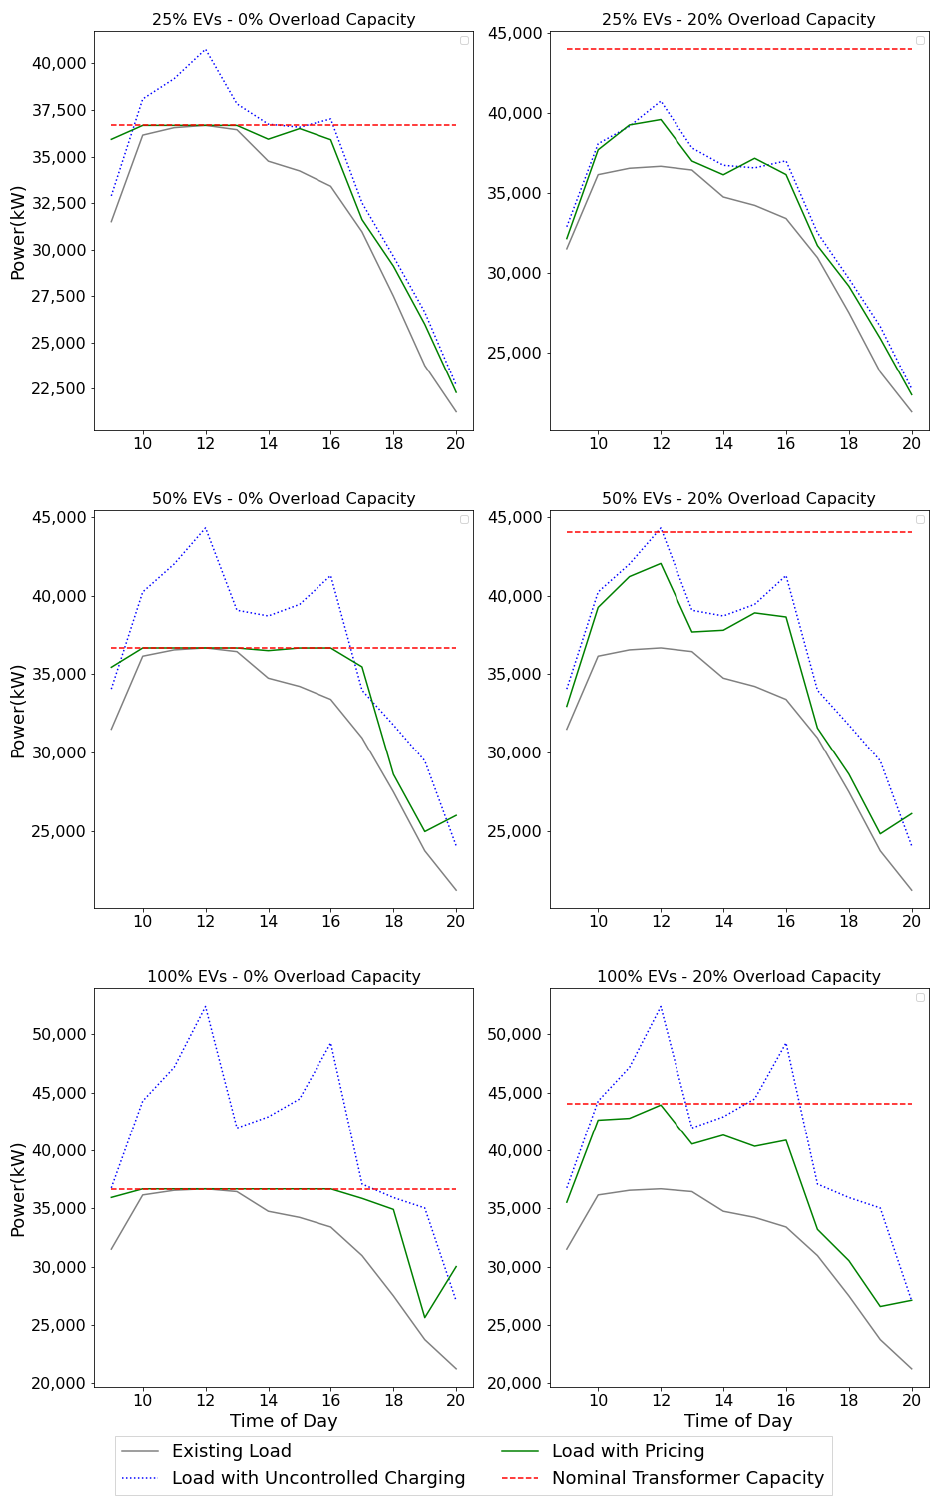
Figure 9. Charging allocation analysis for EV market penetration and overload capacity (Westfield Shopping Centre area). The red dotted line represents the nominal capacity of the distribution transformer; the grey line, the baseline load demand; the blue dotted line, the uncoordinated charging scenario; and the green line; the charging allocation with Fixed Pricing based on time of day (FP).